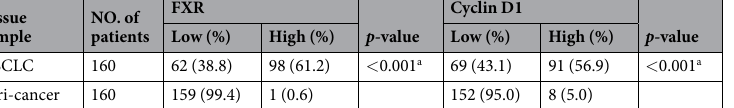
Table 1. Protein expression levels of FXR and cyclin D1 in NSCLC and pericarcinous lung tissues. a Data were analyzed using chi-square test.